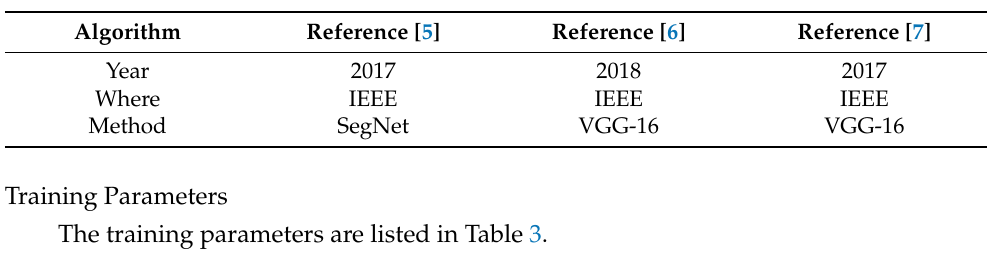
Table 3. Training parameters.